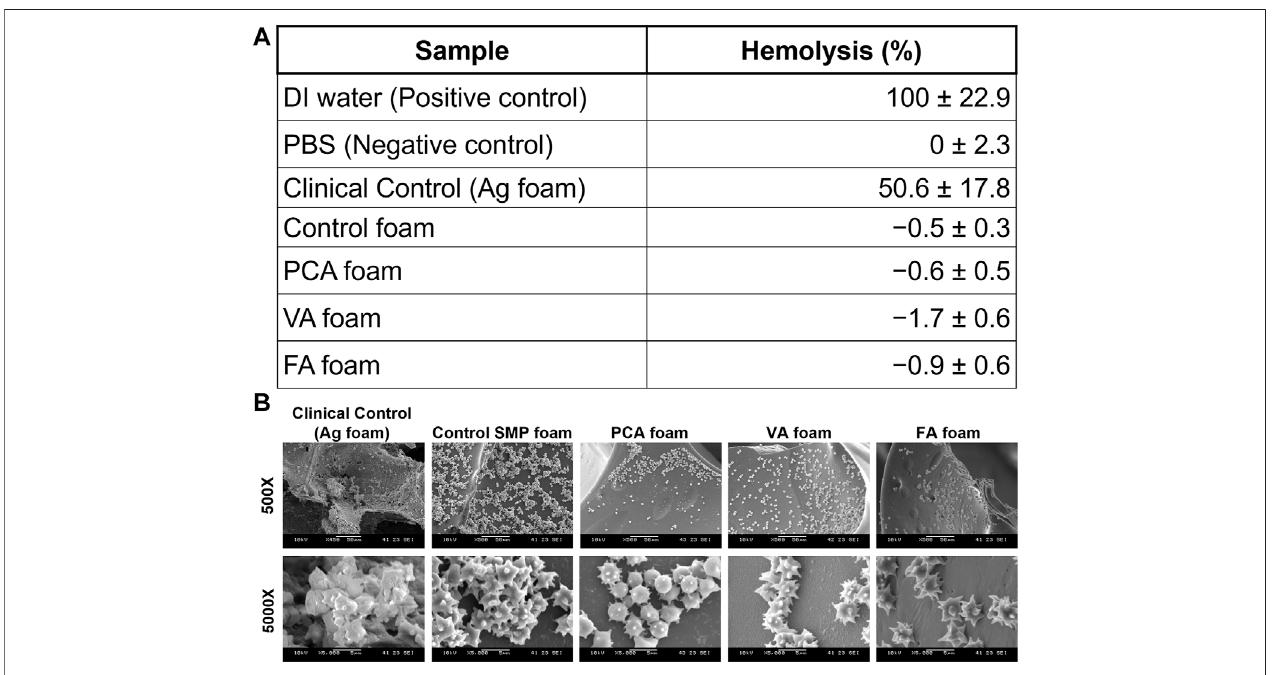
FIGURE 6 | (A) Hemolytic properties of PA-containing SMP foams. n = 3, mean ± standard deviation displayed. (B) SEM images of platelet attachment to